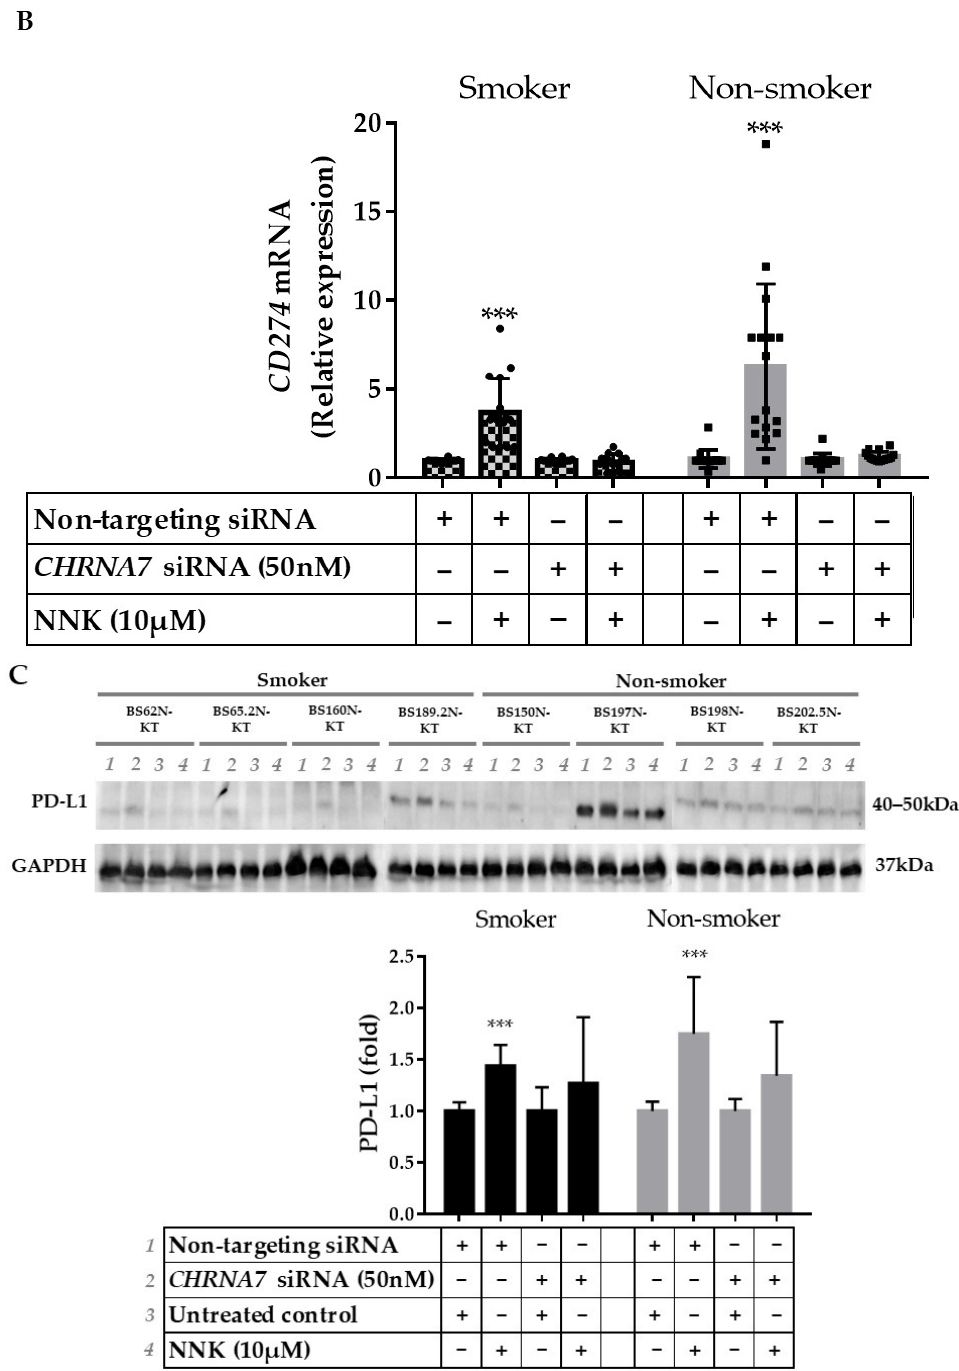
Figure 3. nAChR α 7-mediated NNK-induced PD-L1 expression. ( A ) HBECs were treated with non- targeting or CHRNA7 -specific siRNA (50 nM) for 24 h, and the expression of CHRNA7 mRNA was measured by real-time RT-PCR. HBECs with or without knockdown of CHRNA7 by siRNA (50 nM) for 24 h were further treated with NNK (10 μ M) for another 48 h; the expression of CD274 (PD-L1) ( B ) mRNA expression was measured by real-time RT-PCR; ( C ) protein expression was determined by Western blot analysis. The values are presented as mean ± S.D. from technical triplicate experiments. *** p < 0.001.